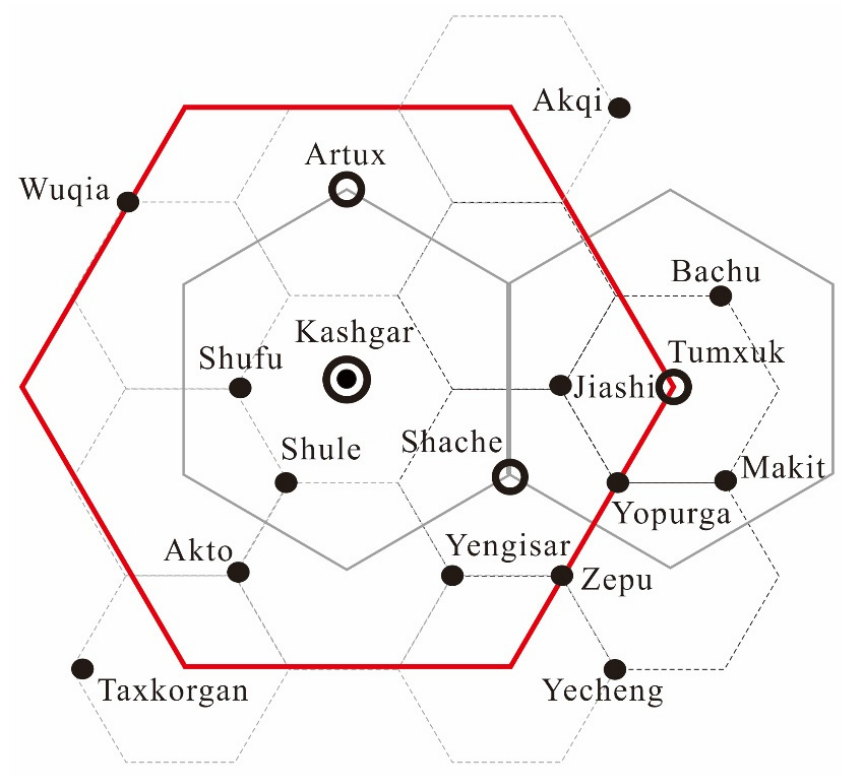
Figure 9. An abstract schematic diagram of the urban spatial form of KMA.